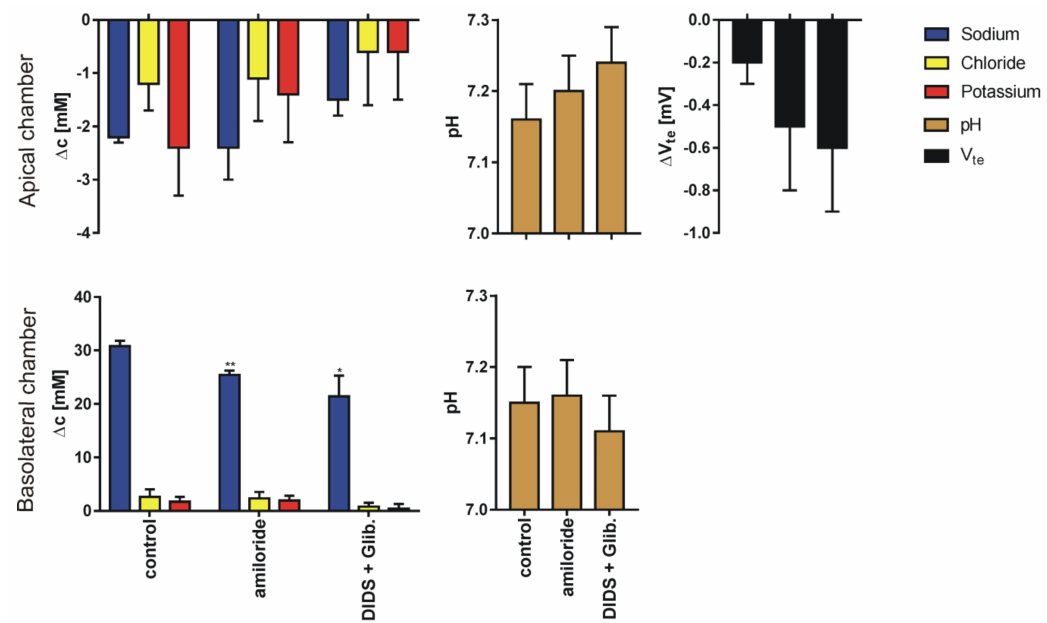
Figure 4. The results (Mean ± SD) of experiments performed in reversed sodium gradient (apical side, KHS1; basolateral side, KHS2) in control conditions and after supplementation of the solution with ion channel blockers. The graph represents: sodium, chloride, potassium transport across epithelial cell monolayer expressed as the concentration change measured 10 min after appropriate solution flow stop; final pH value and the transepithelial potential di ff erence change (N = 7–12 for Cl − , Na + and V te , N = 6 for K + and pH, dependent sample t-test, * p < 0.05, ** p < 0.01, *** p < 0.001). Note di ff erent scales for apical and basolateral graphs.